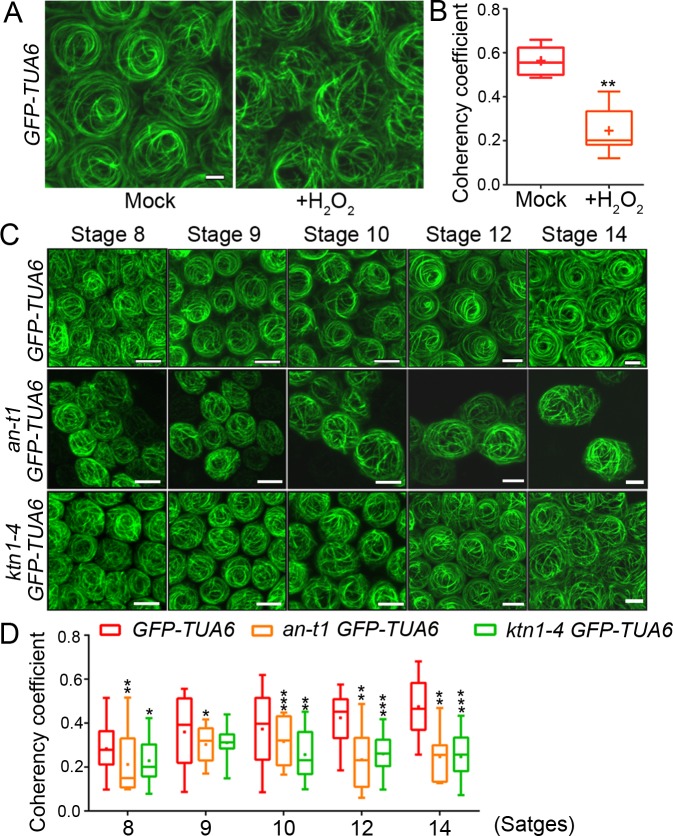
ROS-dependent microtubule orientation during conical cell shaping.(A) Exogenously supplied 100 mM H2O2 suppressed microtubule orientation into well-ordered circumferential arrays. Scale bar represents 5 μm. Representative confocal images were generated by top-down 2D maximum projections of Z-stacks. (B) Quantification of microtubule alignment. The microtubule alignment measurement was carried out with "OrientationJ", a ImageJ plug-in, to calculate the directional coherency coefficient of the fibers. A coherency coefficient close to 1 represents a strongly coherent orientation of the microtubules. Asterisks indicate a significant difference (Mann–Whitney U test, **P < 0.01) (P = 0.00233). Values are given from more than 70 cells of 15 petals. (C) Visualization of microtubules in conical cells of wild type, an-t1, and the ktn1-4 mutant at the indicated developmental stages. Representative confocal images were generated by top down 2D maximum projections of Z-stacks. Scale bars represent 5 μm. (D) Quantification of microtubule alignment in conical cells. Asterisks indicate a significant difference (Mann–Whitney U test, *P < 0.05, **P < 0.01, ***P < 0.001) (from left to right, P = 0.0071, P = 0.03454, P = 0.02066, P = 0.05546, P = 0.00063, P = 0.00422, P = 0.00307, P = 0.00054, P = 0.00105, P = 0.00057). For all genotypes, n = 80 cells from 15 petals).